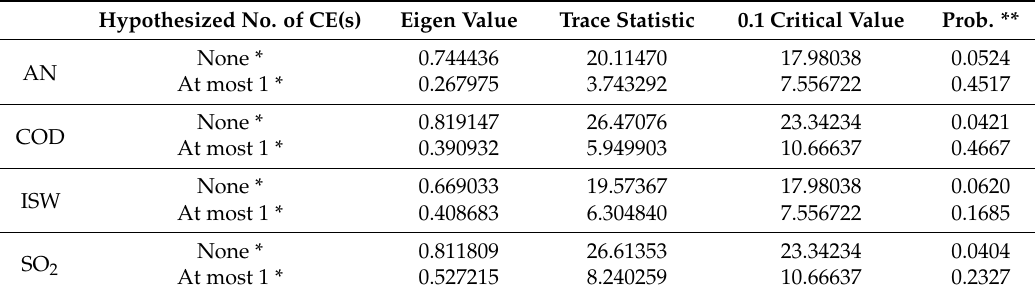
Table 11. Johansen co-integration test for non-metal ore mining and processing.